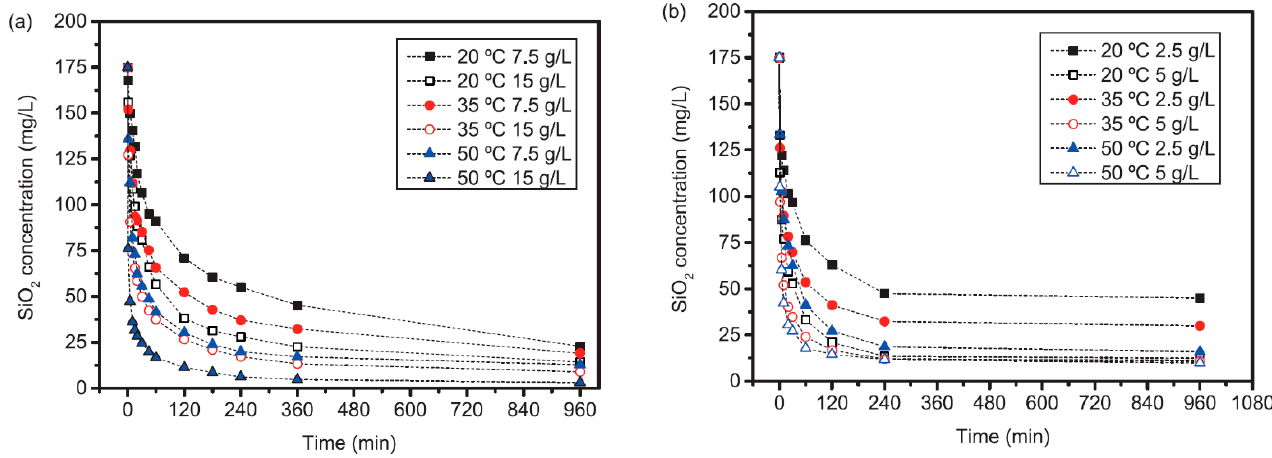
Figure 5. Kinetics of silica adsorption on ( a ) pseudoboehmite and ( b ) γ -Al 2 O 3 (experimental conditions: initial pH 8.5, dosages and temperatures in the legend).